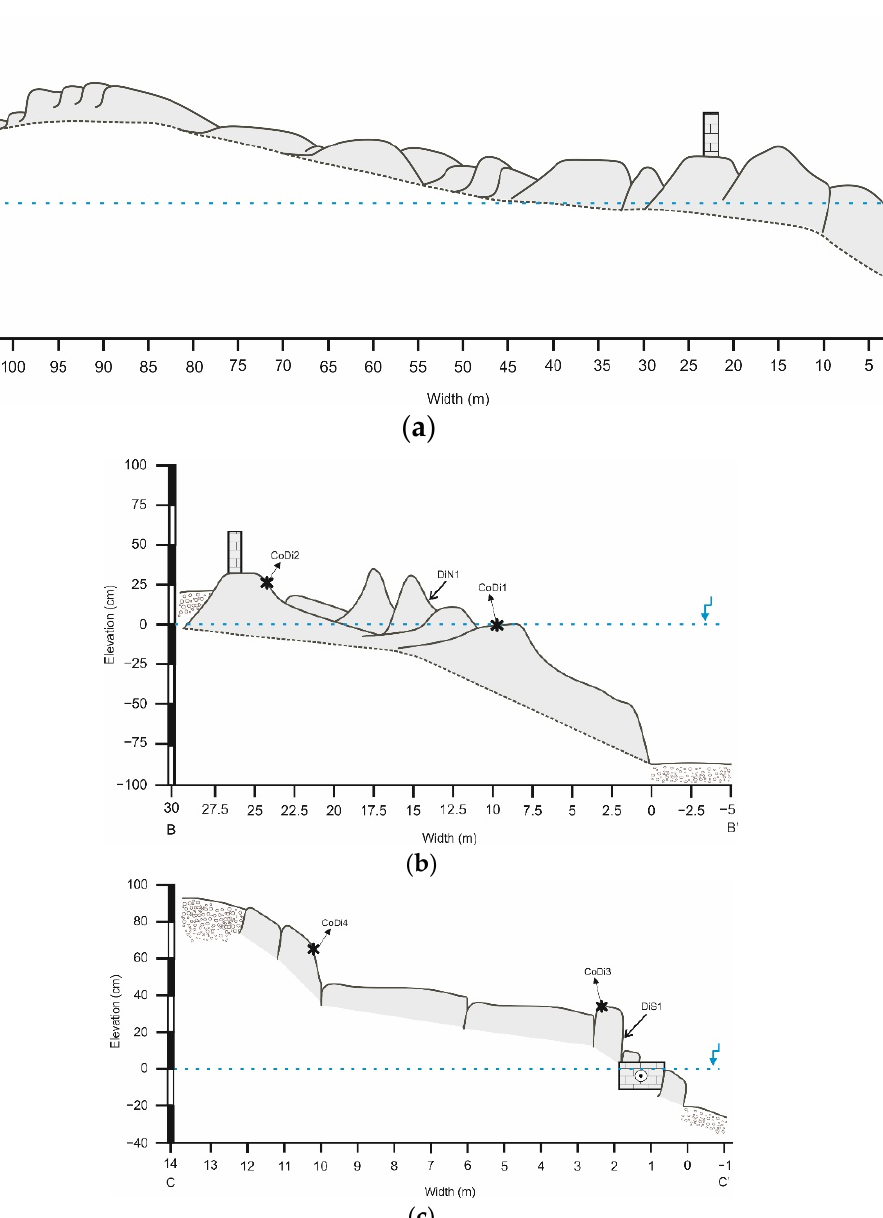
Figure 4. Schematic representation of Diolkos beachrock cross sections and sample points. The blue line represents the m.s.l. ( a ) A cross section of the northern beachrock part. At 22 m width, a wall construction is present. ( b ) A cross section of the northern beachrock part. At 26 m width, a wall construction is present. The star shaped points indicate the samples for microscopic analysis, and the arrow point at the cross section indicates the OSL dating sample. ( c ) A cross section of the southern beachrock part. At 1 m width, a Diolkos remnant is fused with the beachrock. The star shaped points indicate the samples for microscopic analysis, and the arrow point at the cross section indicates the OSL dating sample.